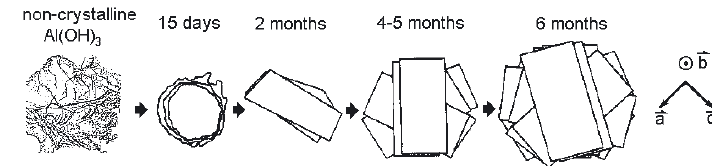
Figure 11. Representation of nordstrandite crystal development in ethylene-glycol/water